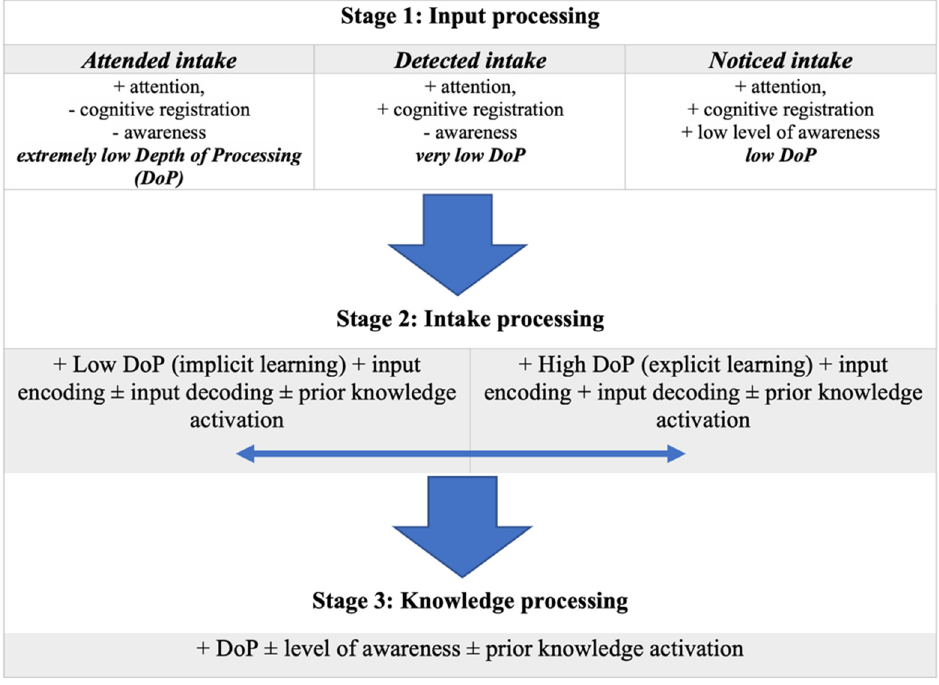
Figure 1. The three processing stages of the L2 learning process (adapted from Leow 2015).